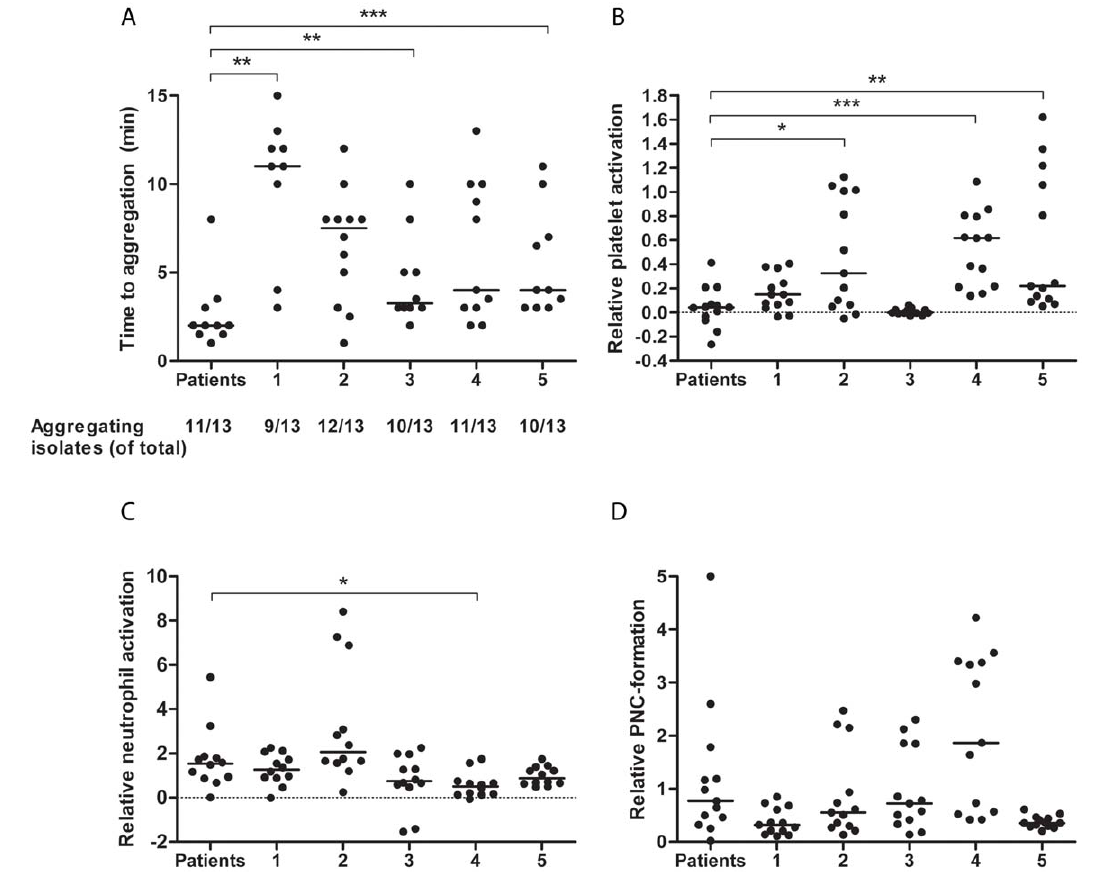
Figure 5. Platelet and neutrophil responses to clinical blood isolates of S.aureus . (A) Time to platelet aggregation in PRP by 13 S. aureus isolates is shown. In the left part of the figure, time to aggregation in PRP of patients with S. aureus bacteremia is shown. Time to aggregation in the five healthy donors (labeled 1–5) is shown in the right part of the figure. In the bottom of the figure, the number of isolates inducing aggregation of platelets is given. (B) The increase in activated platelets by the 13 S. aureus isolates relative to the increase caused by stimulation of ADP is given for the patients and for the five donors (1–5). (C) The increase of MFI of CD11b on neutrophils induced by the 13 S. aureus isolates relative to the increase caused by stimulation of ADP/fMLP is given for the patients and for the five donors. (D) The increase in PNCs induced by the 13 S. aureus isolates relative to the increase caused by stimulation of ADP/fMLP is given for the patients and for the five donors. One value in (D) is above five (8.3) and is depicted on the outer line of the graph. A filled circle represents each isolate. Medians are given as lines. * P , 0.05, ** P , 0.01, *** P , 0.001 after Mann- Whitney U testing.